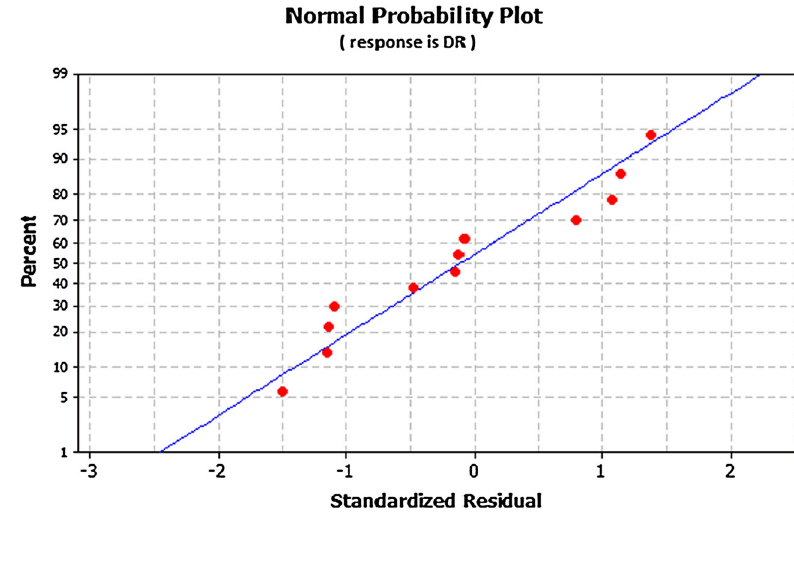
Fig. 9 Normal probability plot of the residuals for